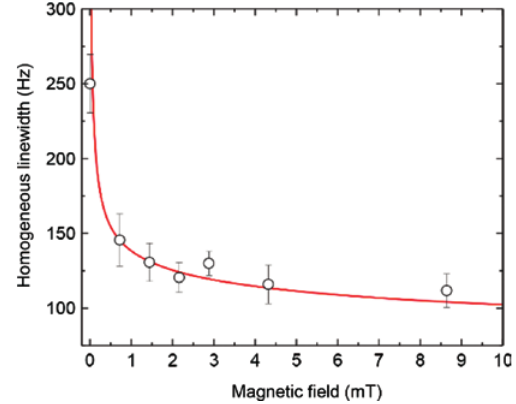
O 2 3 O nanoparticles as a 2 3